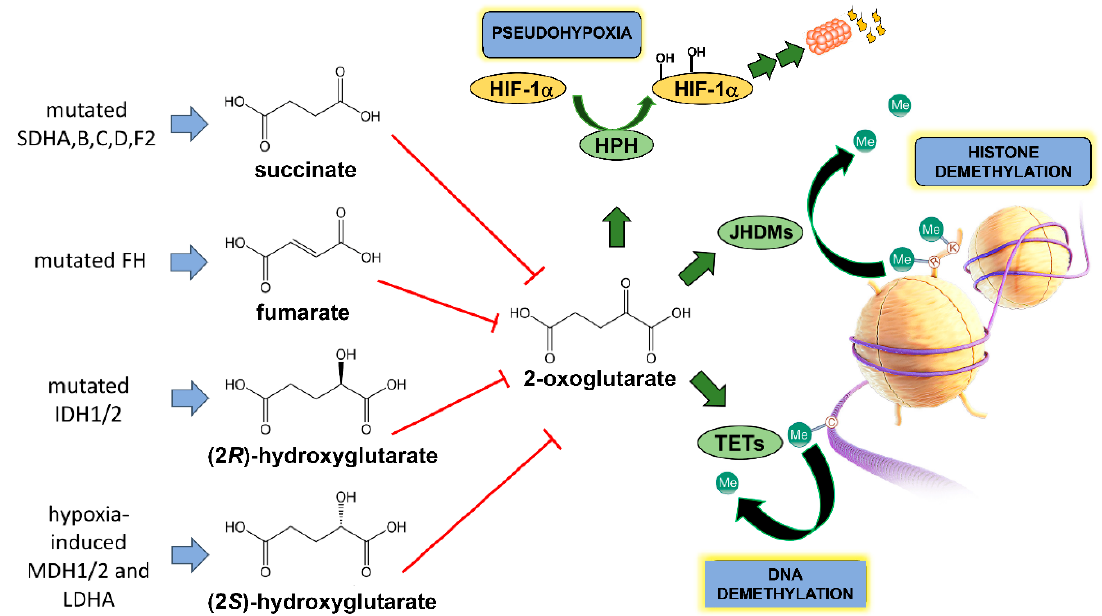
Figure 1. Origin of the four TCA cycle-related oncometabolites and their structural similarity to 2-oxoglutarate. SDHA/B/C/D/F2 represent succinate dehydrogenase complex subunits A–D and succinate dehydrogenase complex assembly factor 2; FH represents fumarate dehydratase; IDH1/2 represent isocitrate dehydrogenase 1 and 2; MDH1/2 represent malate dehydrogenase 1 and 2; LDHA represents lactate dehydrogenase A. HPH is HIF prolyl hydroxylase that leads to HIF-1 α proteasomal degradation, JHDMs are lysine demethylases (Jumonji C domain-containing histone demethylases) and TETs are ten–eleven translocation (TET) methylcytosine dioxygenases.